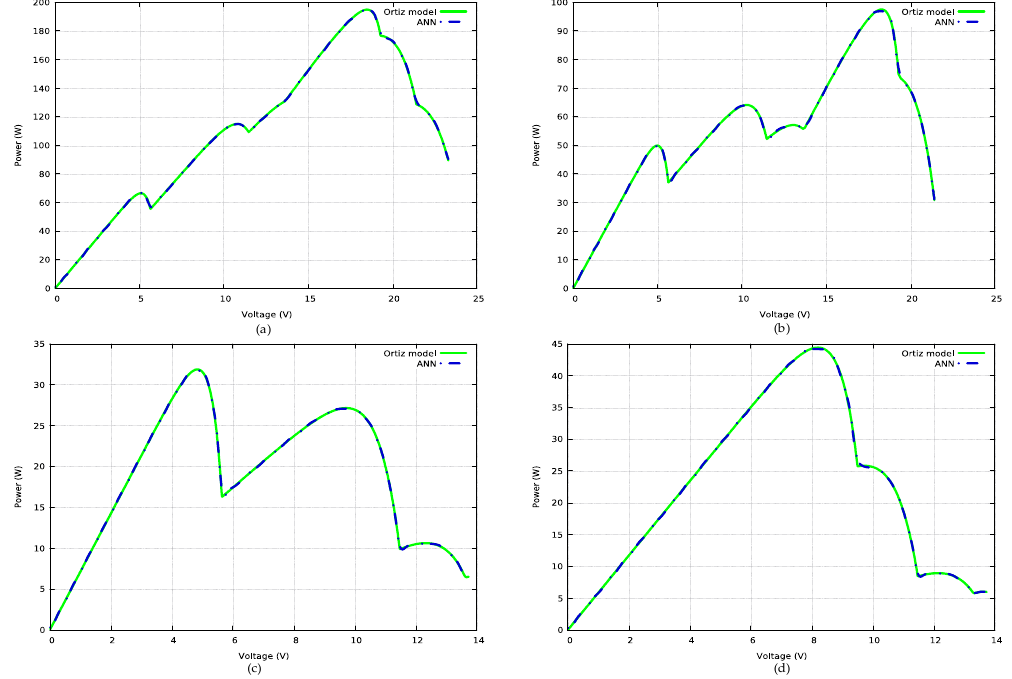
Figure 5. Test functions generated with the neural network: ( a ) Function 0; ( b ) Function 1; ( c ) Function 2; ( d ) Function 3.